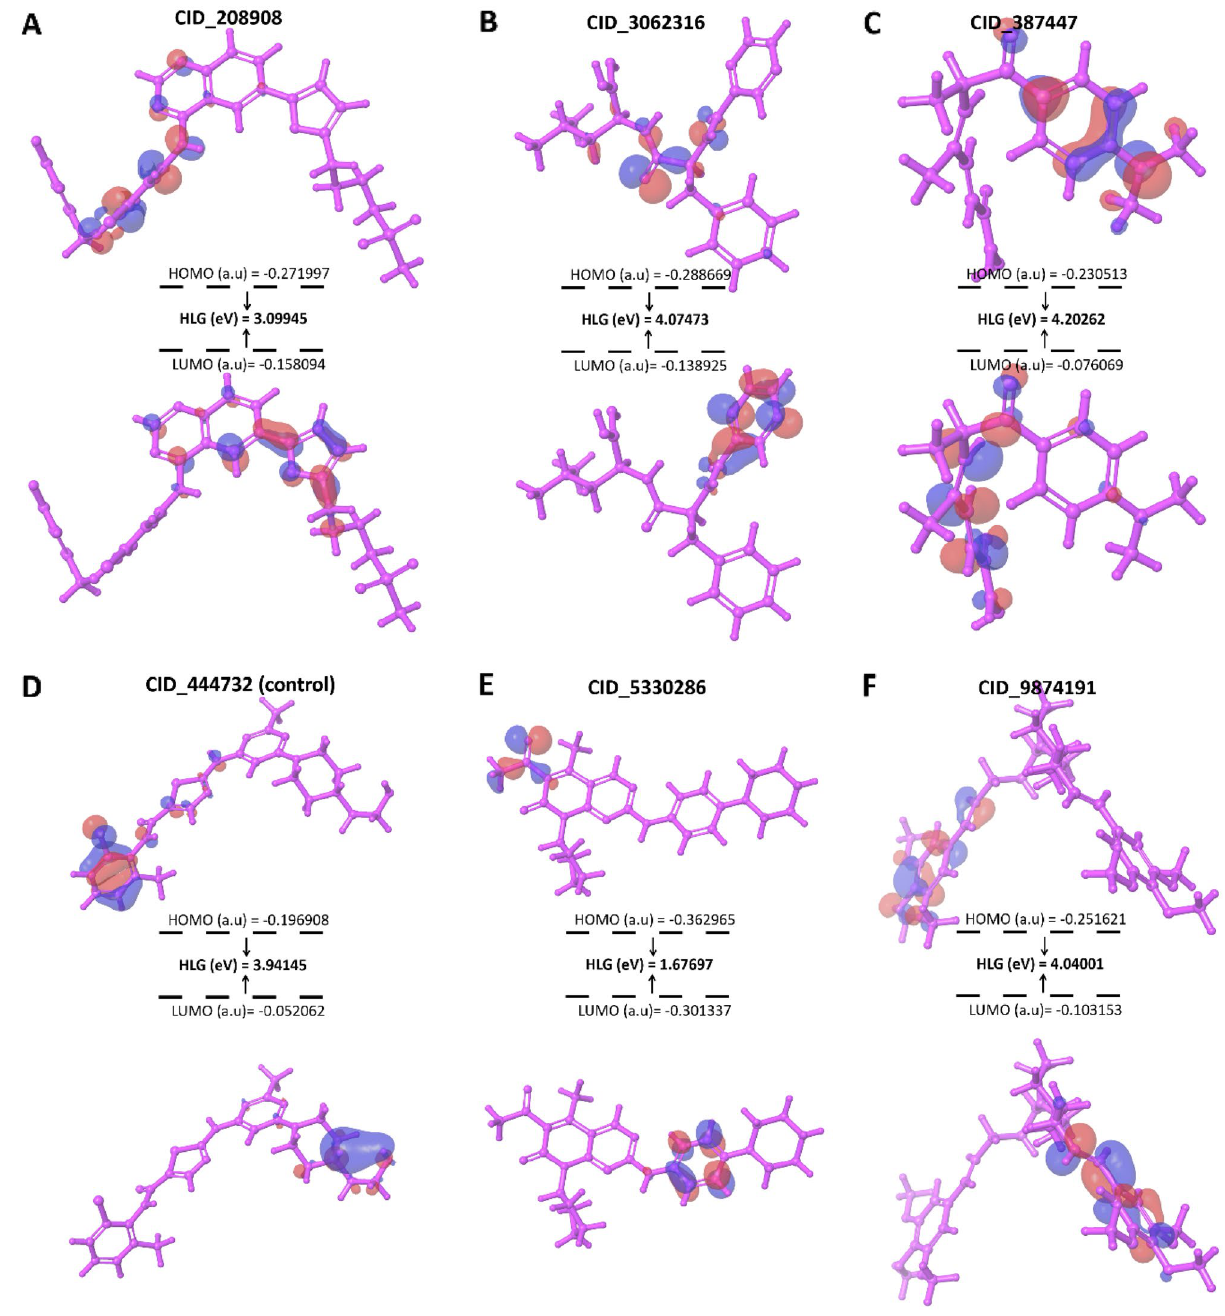
Figure 4. The HOMO and LUMO energy score and structure of the 6 docked compounds were compared with TSA.